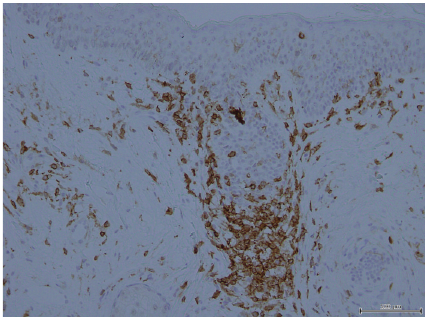
Figure 3: Microscopic findings of skin biopsy; CD4+ cells were infiltrated. These cells were CD3+, but no CD56+ cells or EBER+ cells were detectable. Also, only a few cells in this dermal area were stained with TIA-1 and Granzyme B (data not